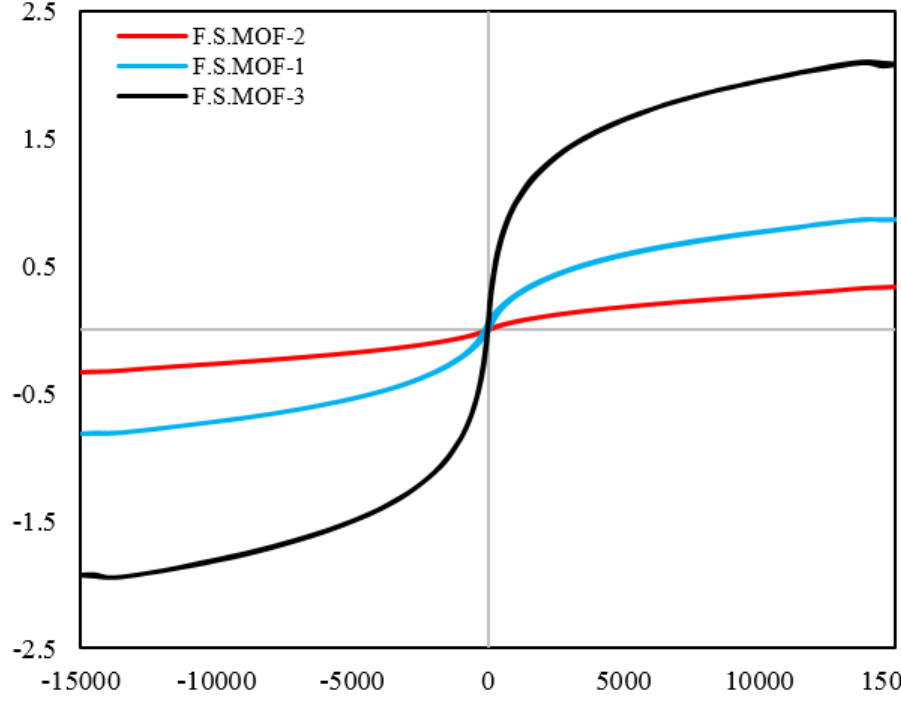
Fig. 10. Vibrating Sample Magnetometer (VSM) Analysis Fig (10): Vibrating Sample Magnetometer (VSM) Analysis